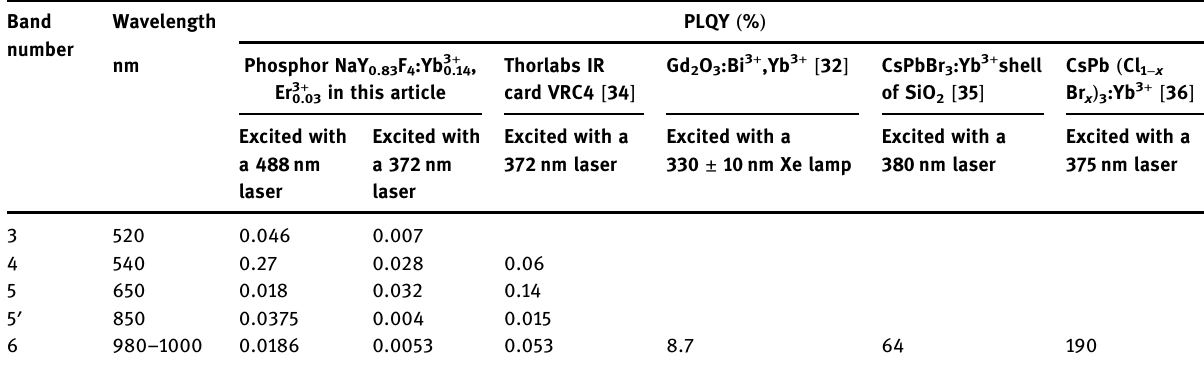
Table 1: PLQY of the synthesized phosphor in comparison with other materials